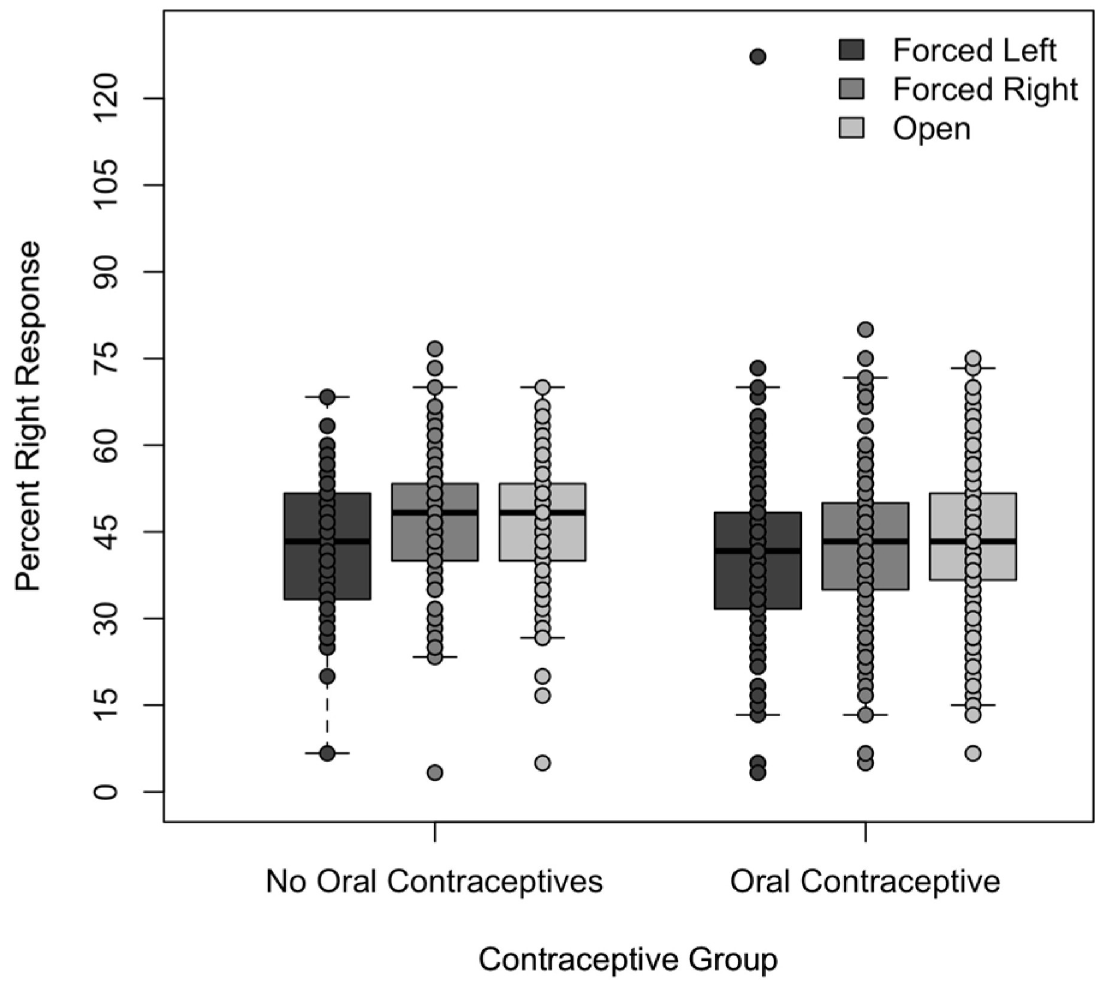
Fig 2. Percentage of right ear responses under the three listening conditions to the two listening groups. Percentage of right ear responses under the forced left, forced right, and open conditions by the women not taking oral contraceptives and those taking oral